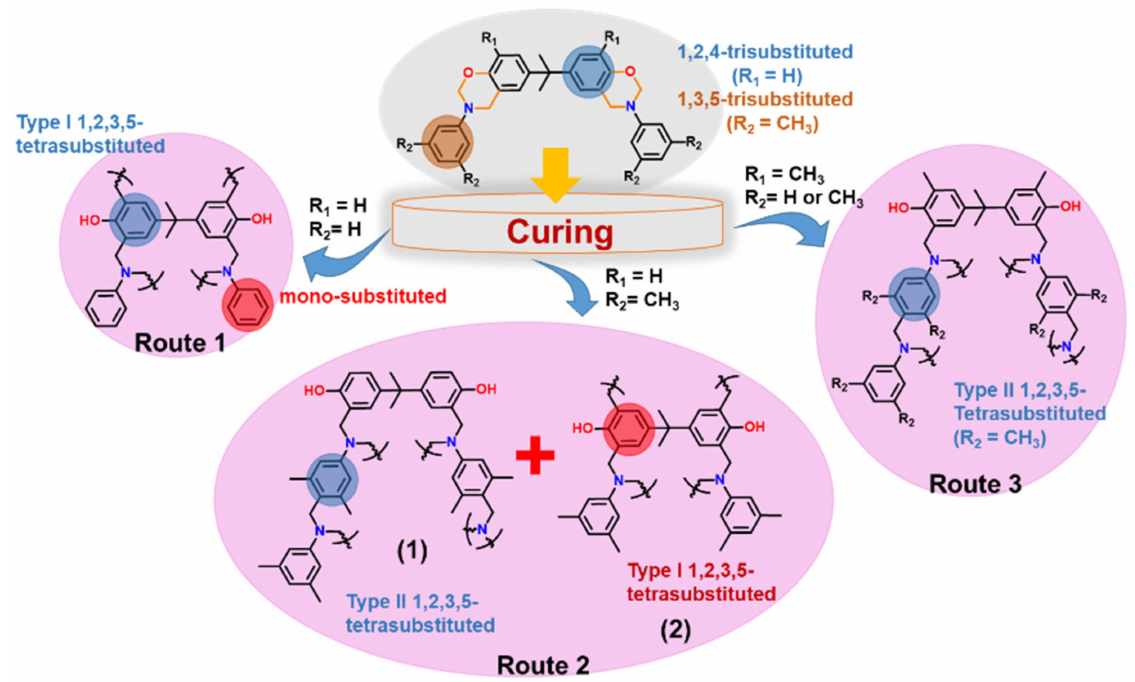
Figure 11. Possible polymerization routes for bisphenol-arylamine-based benzoxazines [83]. Copyright 2018. Reproduced with permission from Elsevier B. V.